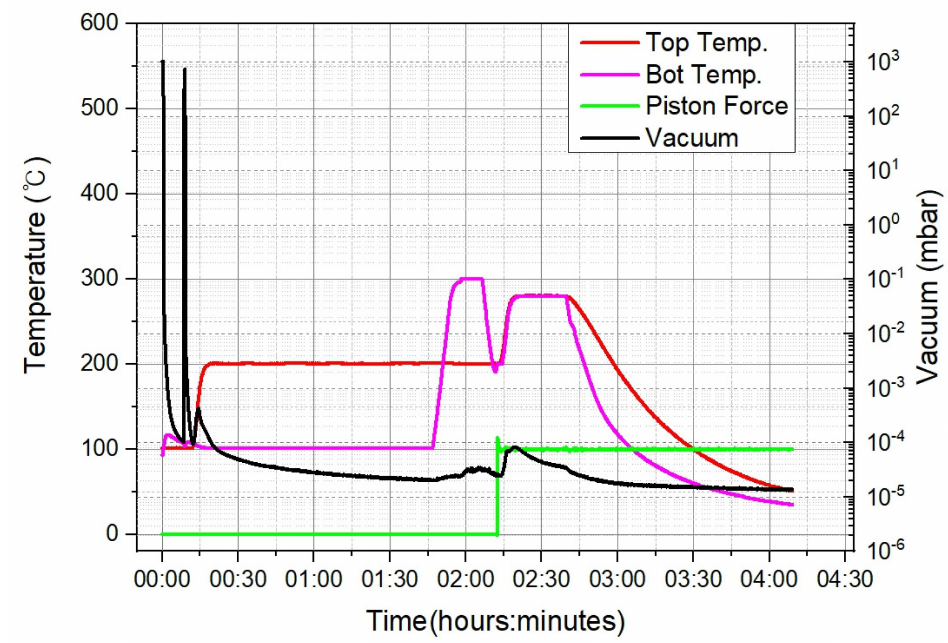
Figure 3. Parameter (temperature, pressure, time) profiles during the bonding